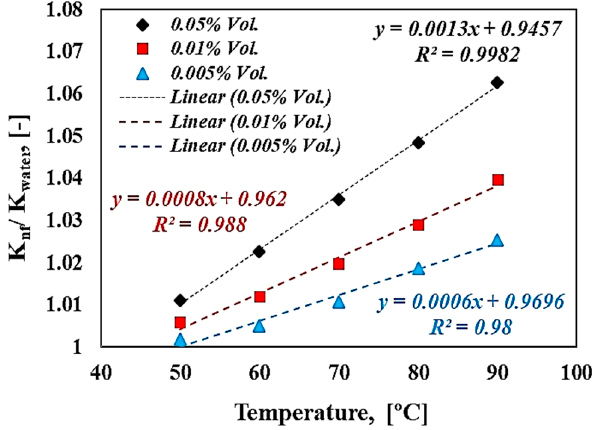
Figure 8. Thermal conductivity ratio at different volume concentrations and temperatures.